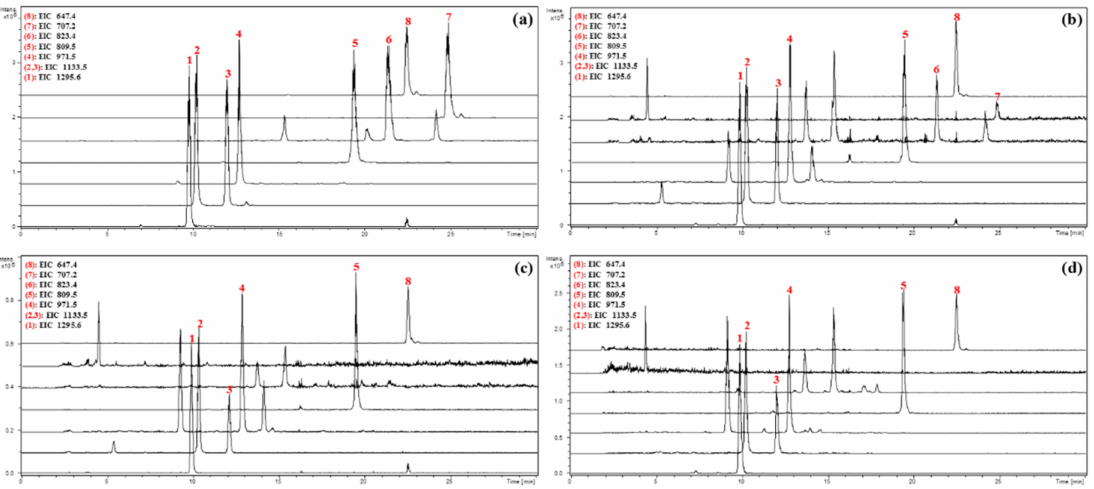
Figure 3. Extract ion chromatogram (EICs) of the reference compounds 1 – 8 and different extracts of O. chiliophylla by extracting m/z 1295.6, 1133.5, 971.5, 809.5, 823.5, 707.5 and 647.5. ( a )